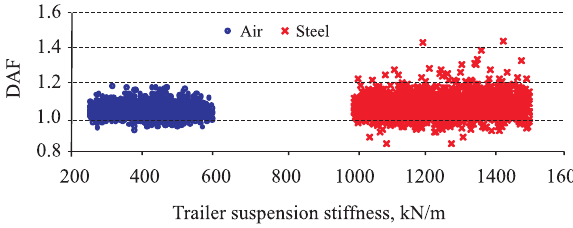
Fig. 5. DAF for 5-axle trucks on simply supported 25 m bridge for class B road profiles and no bump prior to the bridge for trailer air ( ) and steel ( ) suspension